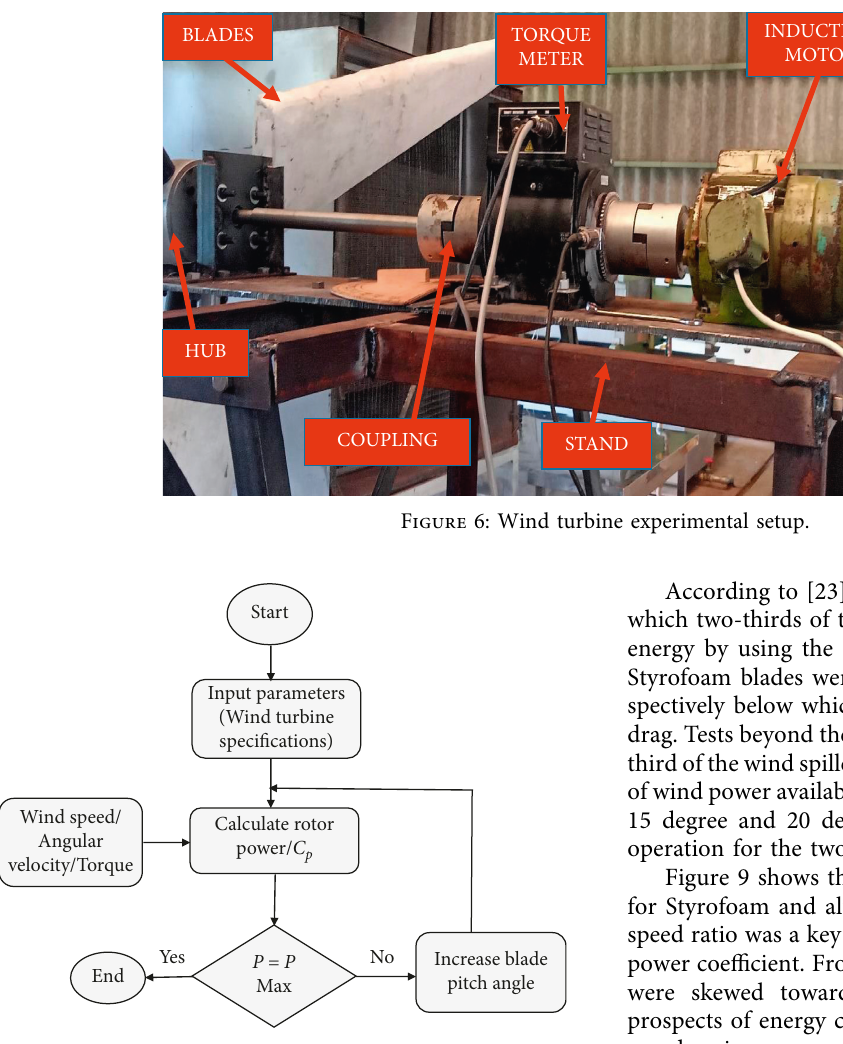
Figure 7: Wind turbine optimization